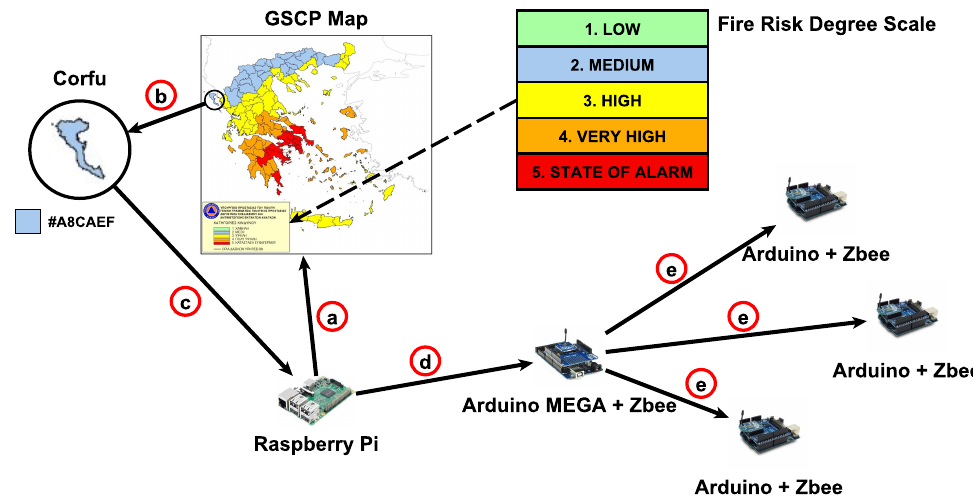
Figure 9. Steps for retrieving the risk degree and relaying the information to a WSN.